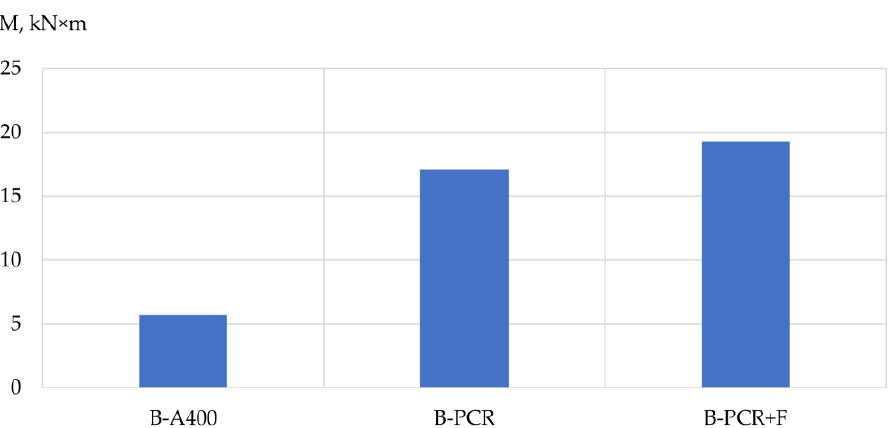
Figure 7. Dependence of the bearing capacity of specimen beams on the type of reinforcement used: B-A400 is a specimen beam reinforced with steel reinforcement of class A400; B-PCR is a sample beam reinforced with polymer composite reinforcement; B-PCR+F is a sample beam reinforced with polymer composite reinforcement and glass fiber.